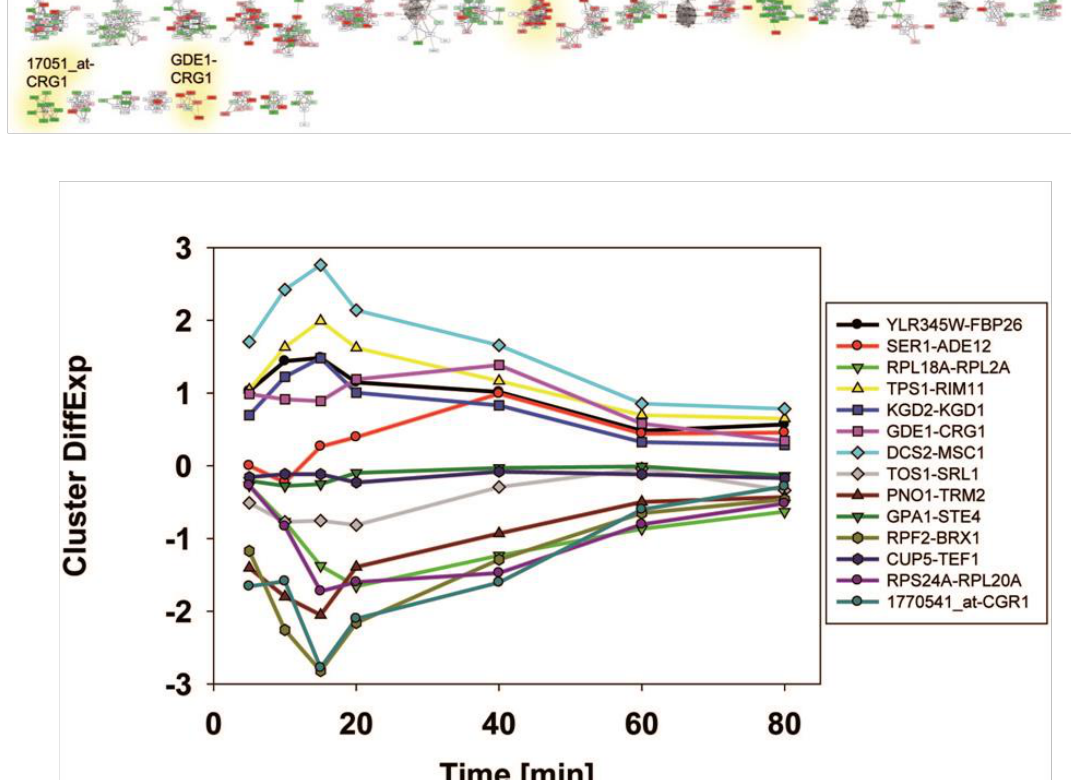
OPEN ACCESS | www.microbialcell.com